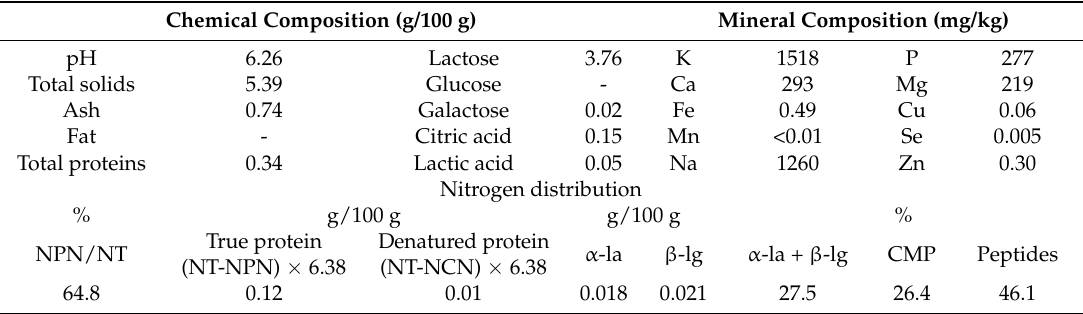
Table 1. Chemical composition, nitrogen distribution, and mineral composition of ricotta cheese whey